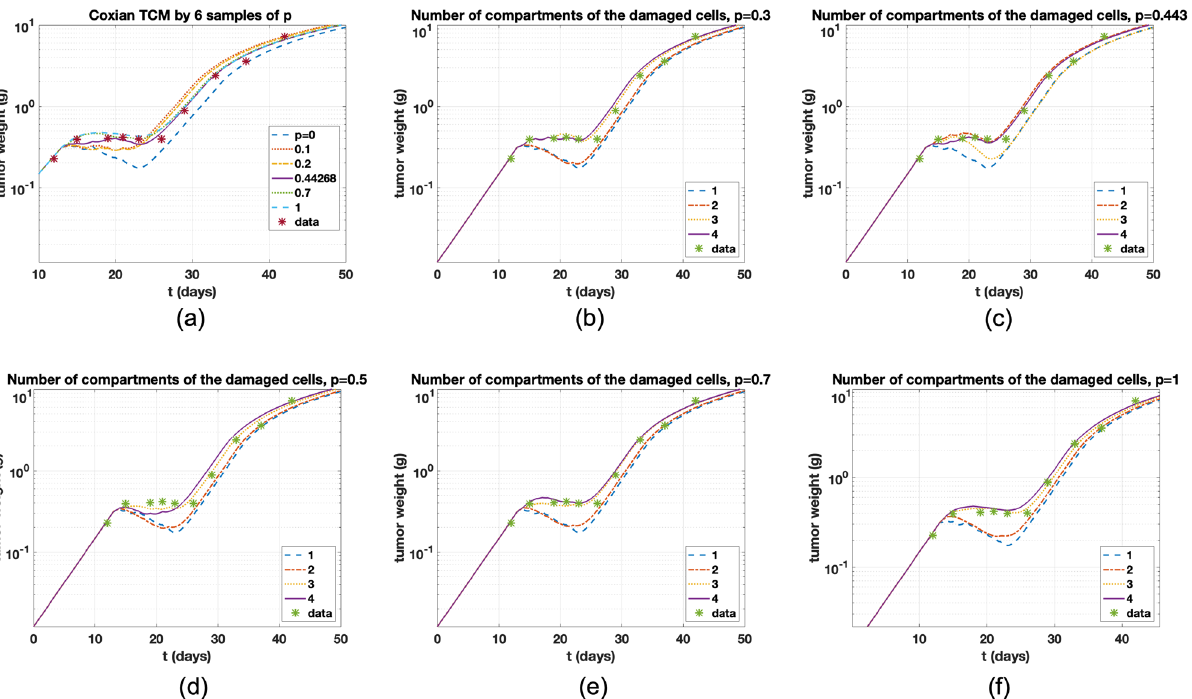
Figure 4. ( a ) For the change of delay, dynamics of Coxian TCM are investigated by various p ’s. The number of the compartments of the damaged cells is n = 4 . p = 1 represents Erlang TCM. ( b )–( e ) Delays are differently determined by the number of the compartments depending on p . Delay is not followed as regular sequences. ( f ) In Erlang TCM, tumor delay follows the regular sequence.